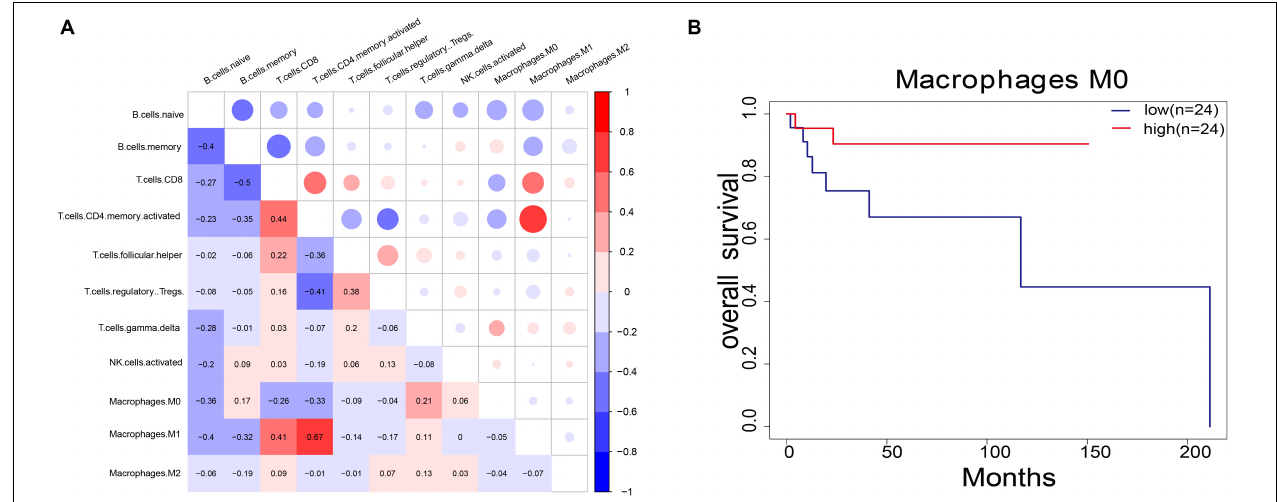
FIGURE 5 | (A) Pairwise relationship between immune cell abundance ratios. The numerical values represent the correlation value. Red represents a positive correlation; blue represents a negative correlation. (B) Survival analysis of DLBCL patients according to the abundance ratio of M0 macrophages ( P = 0.08). The red line indicates the high expression group, and the blue line indicates the low expression group.